Question: Generate an informative caption for the figure above.
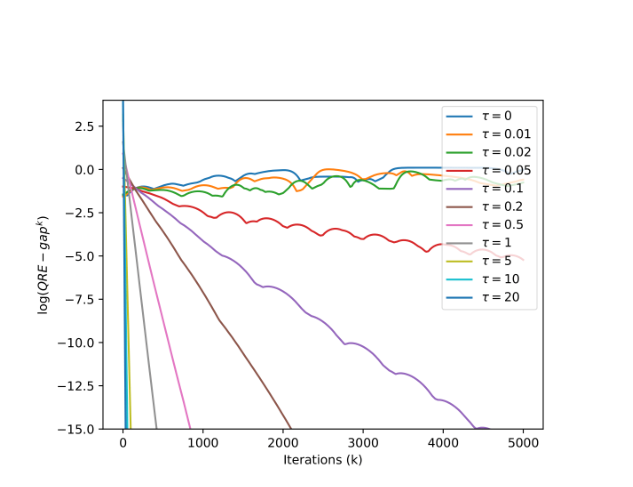
Answer: Convergence of QRE-gap in random game with different τ.